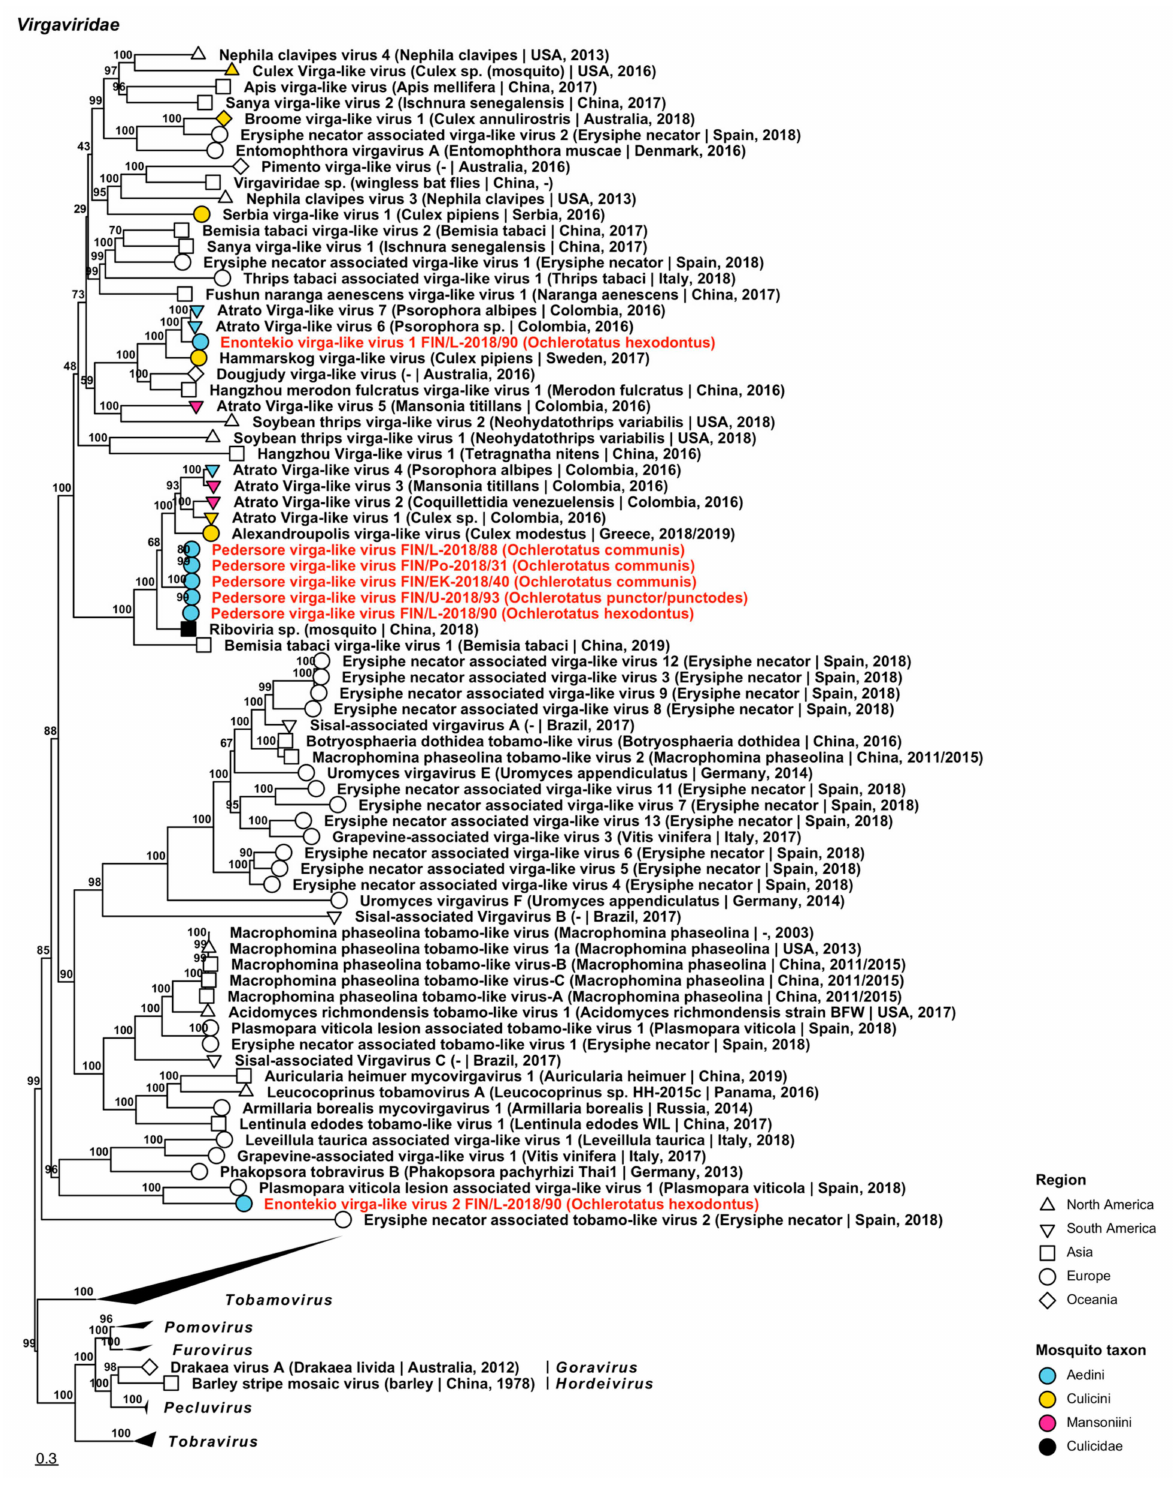
Figure 9. Maximum likelihood tree of Virgaviridae . Tentative novel viruses are displayed in red and the mosquito species from which they were derived are in parentheses. Sequences from GenBank are black and display the following information after the virus or species name: “(sampled organ- ism(s)|collection country, collection year)”. Tip colours represent the tribe of mosquito from which viruses were obtained. Tip shape represents the continent or region from which the specimens were collected. Trees were constructed from amino acid sequences of virus polymerases >1000 nt, aligned with MAFFT and computed with IQ-TREE2 using ModelFinder and 1000